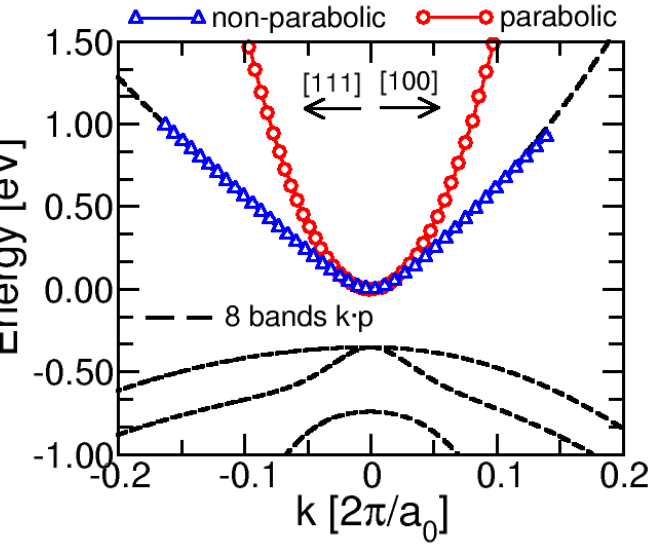
Figure 3. Dispersion relationship of the Γ valley of InAs. The 8-band k · p of [9] (with the parameters for InAs from [29]) is compared with the parabolic and non-parabolic analytical expressions.